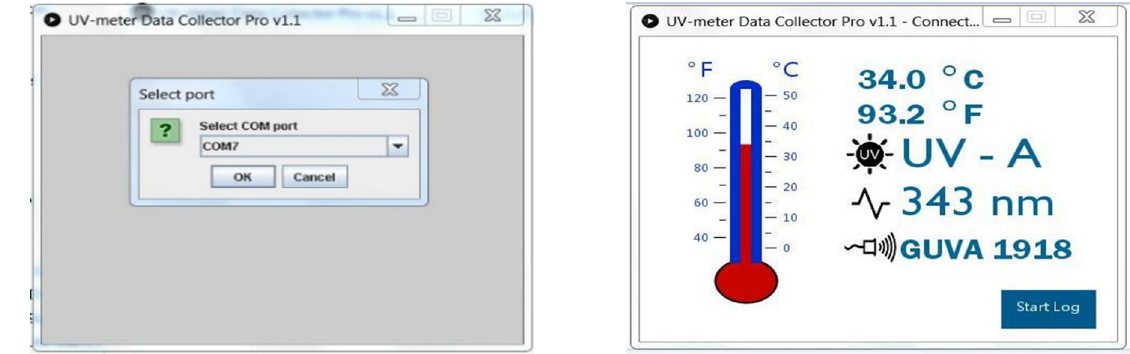
Figure 10. UV-meter Data Collector Pro v1.1 PC data logging software.